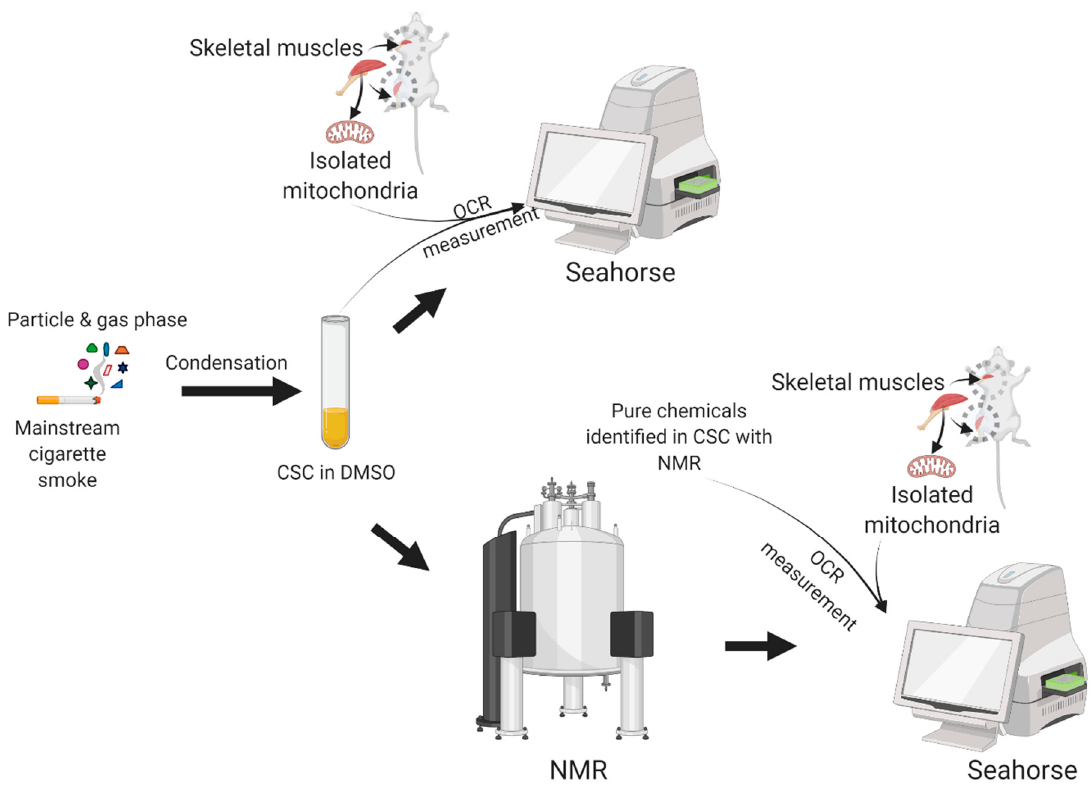
Figure 1. Schematic diagram for the overall workflow employed in this study including CSC sample generation, tissue collection, respirometric analysis using Seahorse instrument, and NMR screening of CSC to identify the chemicals present in CSC. OCR: oxygen consumption rate, NMR: nuclear magnetic resonance, CSC: cigarette smoke condensate.